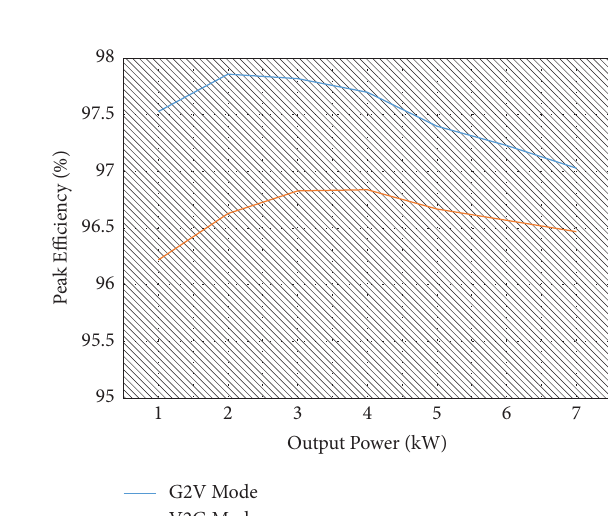
Figure 9: SR fip-fop block diagram.